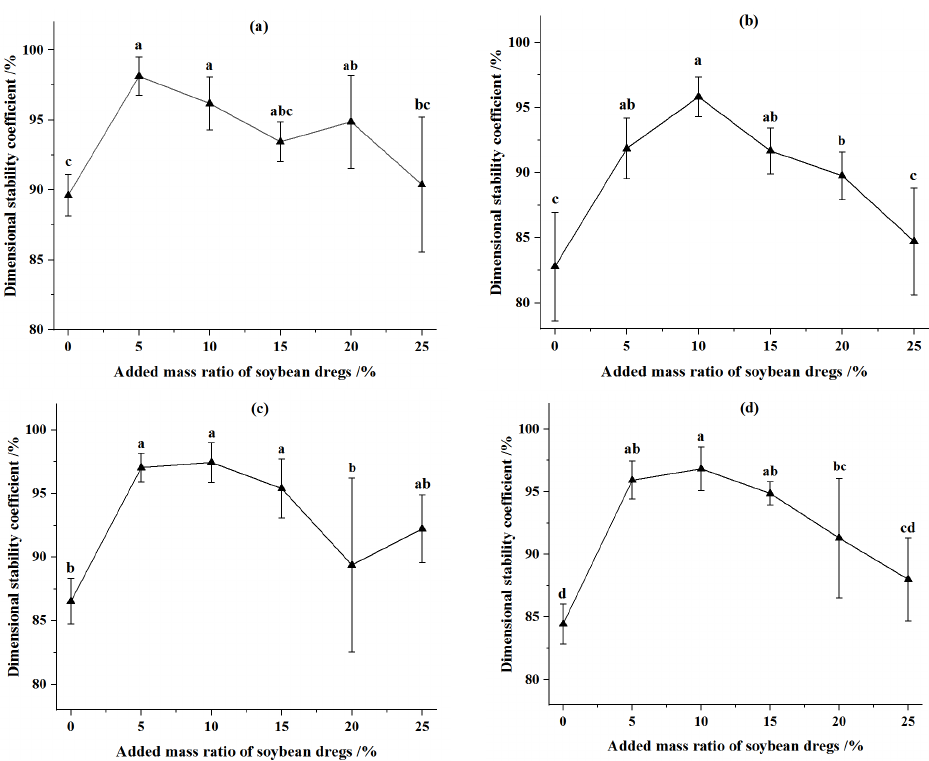
Figure 4. Effect of added mass ratio of fermented soybean dregs on dimensional stability coefficient of pellets. ( a ) Particle size was 2 mm and compression displacement was 90 mm. ( b ) Particle size was 4 mm and compression displacement was 90 mm. ( c ) Particle size was 2 mm and compression displacement was 92 mm. ( d ) Particle size was 4 mm and compression displacement was 92 mm. Note: Different letters in the same line chart indicate a significant difference between the data ( p <